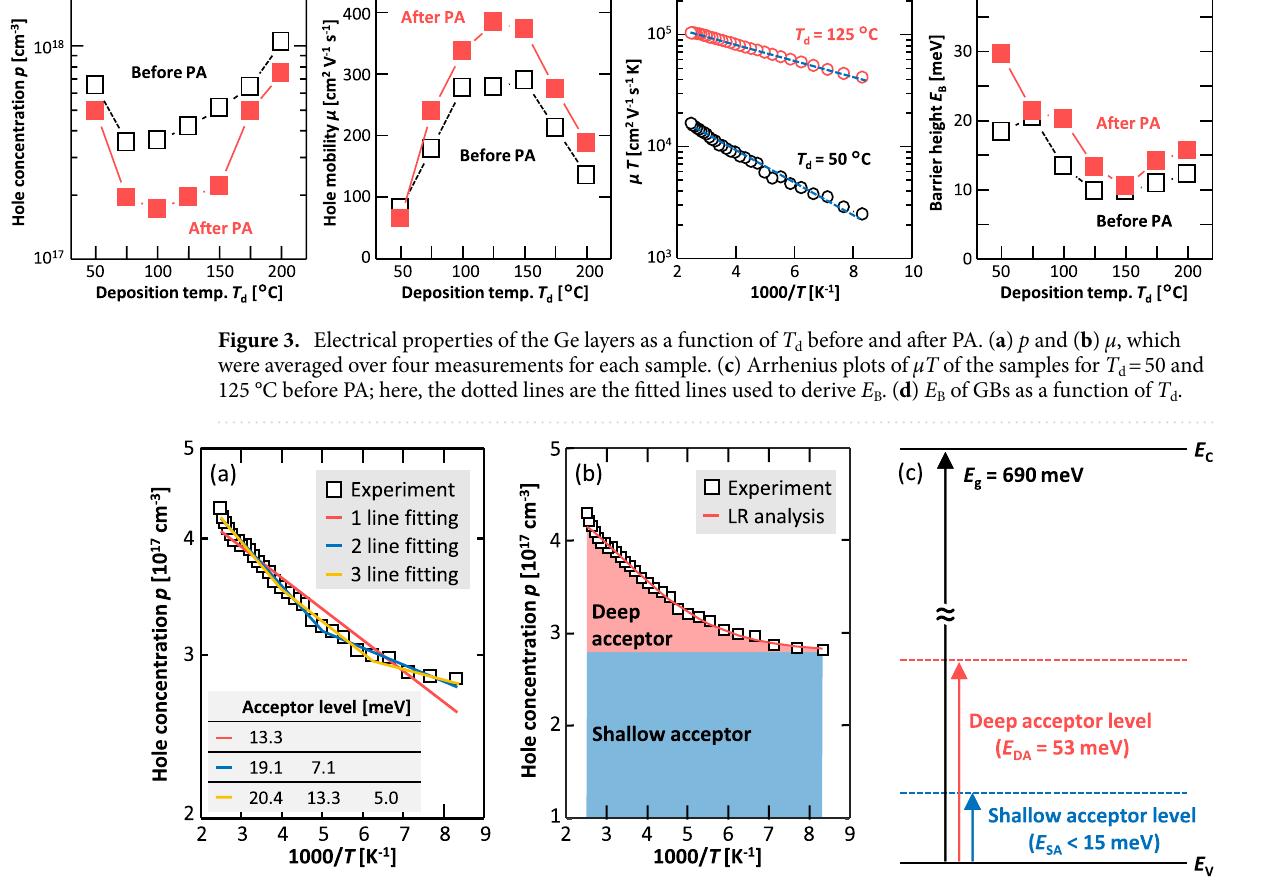
Figure 4. Characterization of the acceptor levels for the sample with T d = 125 °C before PA. ( a,b ) Dependence of p on the measured temperature T , analyzed using ( a ) conventional linear fitting and ( b ) linear regression (LR) analysis. The acceptor levels determined by the linear fitting are shown in ( a ). ( c ) Acceptor levels shown in the bandgap structure of Ge, determined by the linear regression